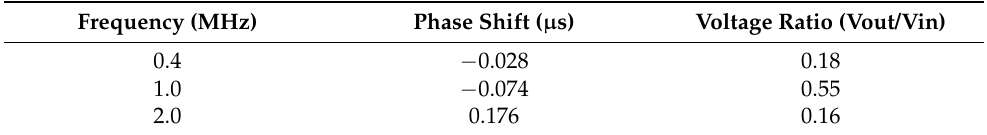
Table 3. Results of the effects of change in frequency on the